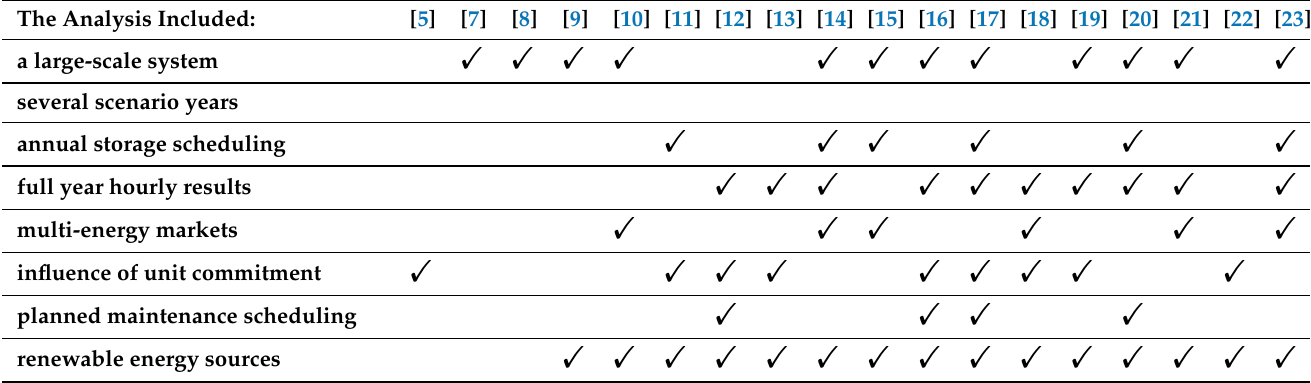
Table 1. Coverage of existing literature on day-ahead market